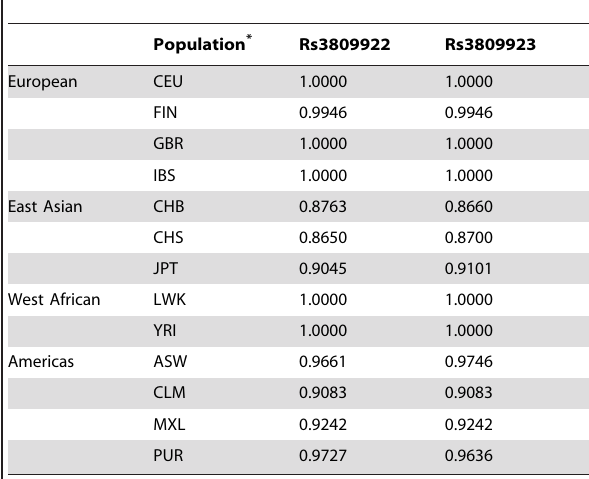
Table 6. Ancestral allele frequency of rs3809922 C and rs3809923 C in different populations based on data from the 1000 Genomes